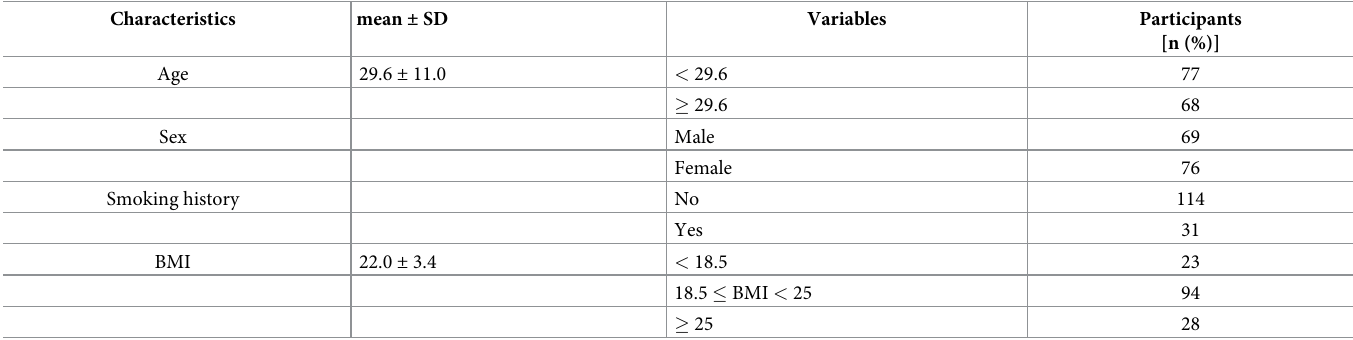
Table 1. Characteristics of the study participants.